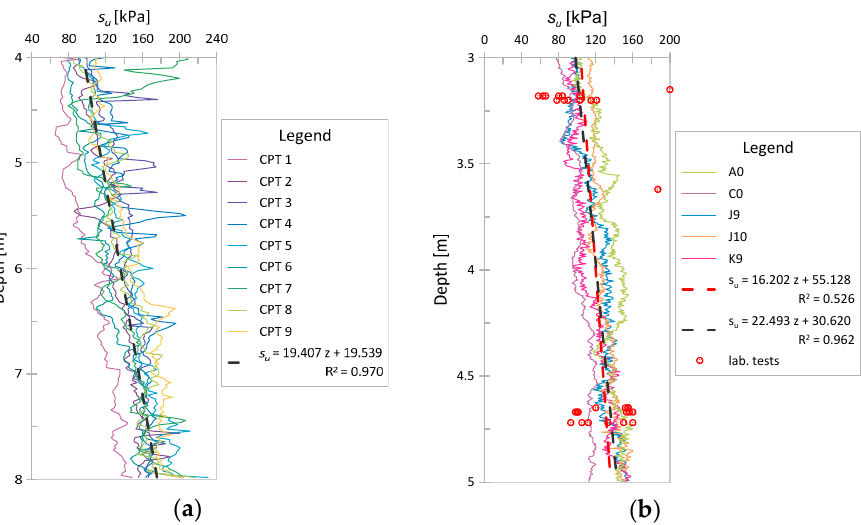
Figure 8. The s u values base on CPT vs. depth. Mean value marked with the black line; ( a ) CPTs for Ś wierzna clay; ( b ) CPTs for Keswick clay.